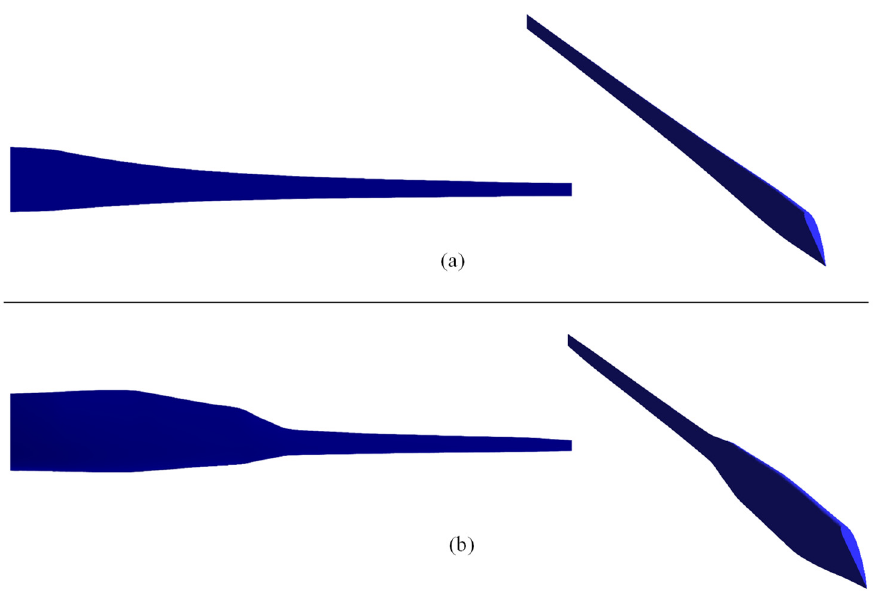
Figure 11. The geometry of the base ( a ) and designed ( b ) blades. The steady-state, RANS form of governing equations, and Shear Stress Transport (SST) k- ω turbulence model were considered for the simulations that were carried out for the base/designed blades using the ANSYS Fluent software [43]. The second-order upwind technique was used to discretize the convection terms and a semi-implicit (SIMPLE) method was employed for the pressure-velocity coupling. To reduce the computational cost, by applying a periodic boundary condition only one blade was modeled. The computational domain and the chosen boundary conditions are shown in Figure 12.